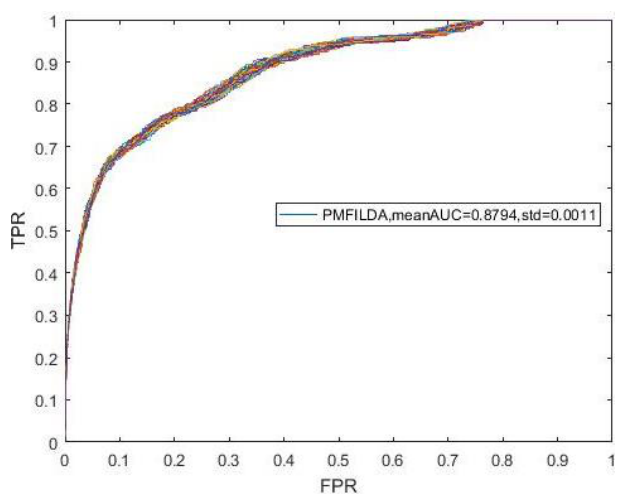
Figure 8. ROC curves and AUCs achieved by PMFILDA based on three association networks.